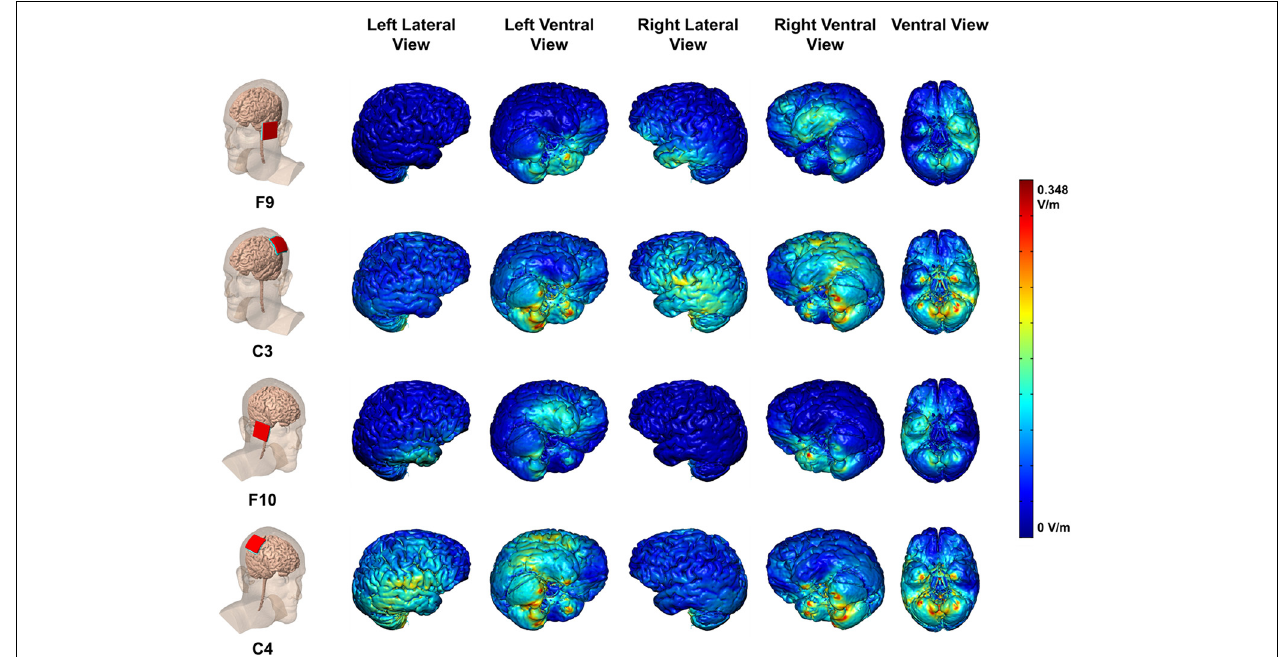
FIGURE 3 | Maps of electric field current flow over cortex for each stimulation montage with cathode on contralateral upper arm. Colors indicate electrical field intensities in V/m per mA. Peak electrical field per 1mA stimulation: 0.348V/m per mA